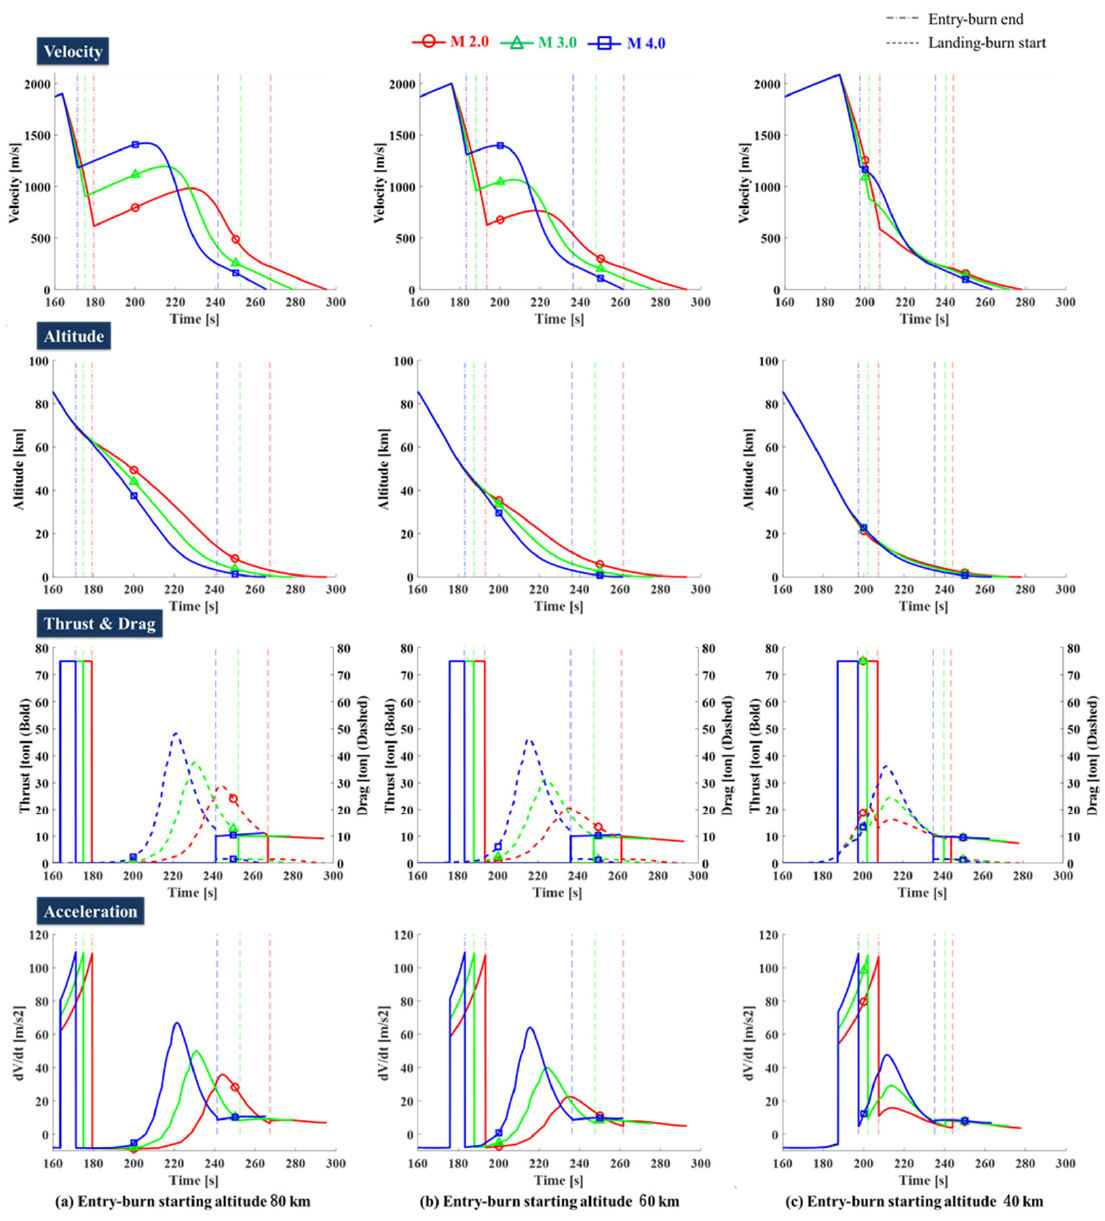
Figure 20. Simulation results with ending Mach number of entry-burn phase. ( a ) Entry-burn starting altitude of 80 km; ( b ) Entry-burn starting altitude of 60 km; ( c ) Entry-burn starting altitude of 40 km.